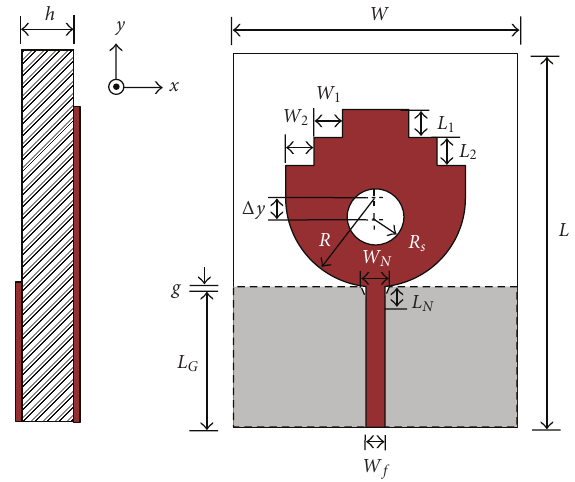
Figure 1: Geometry of a single UWB antenna element with a mi- crostrip line feed, (a) side view and (b) top view.